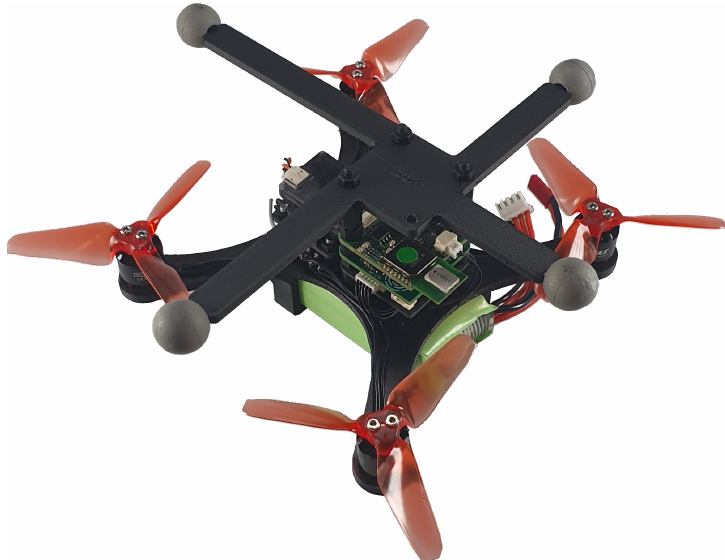
Figure 8. Micro-UAV with optical markers used for the